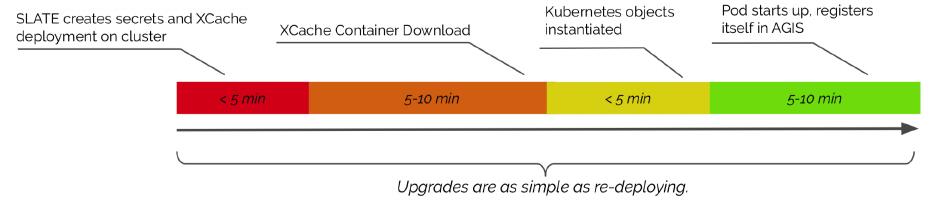
Figure 2: A deployment sequence for an XCache service using the Kubernetes-based SLATE federated edge